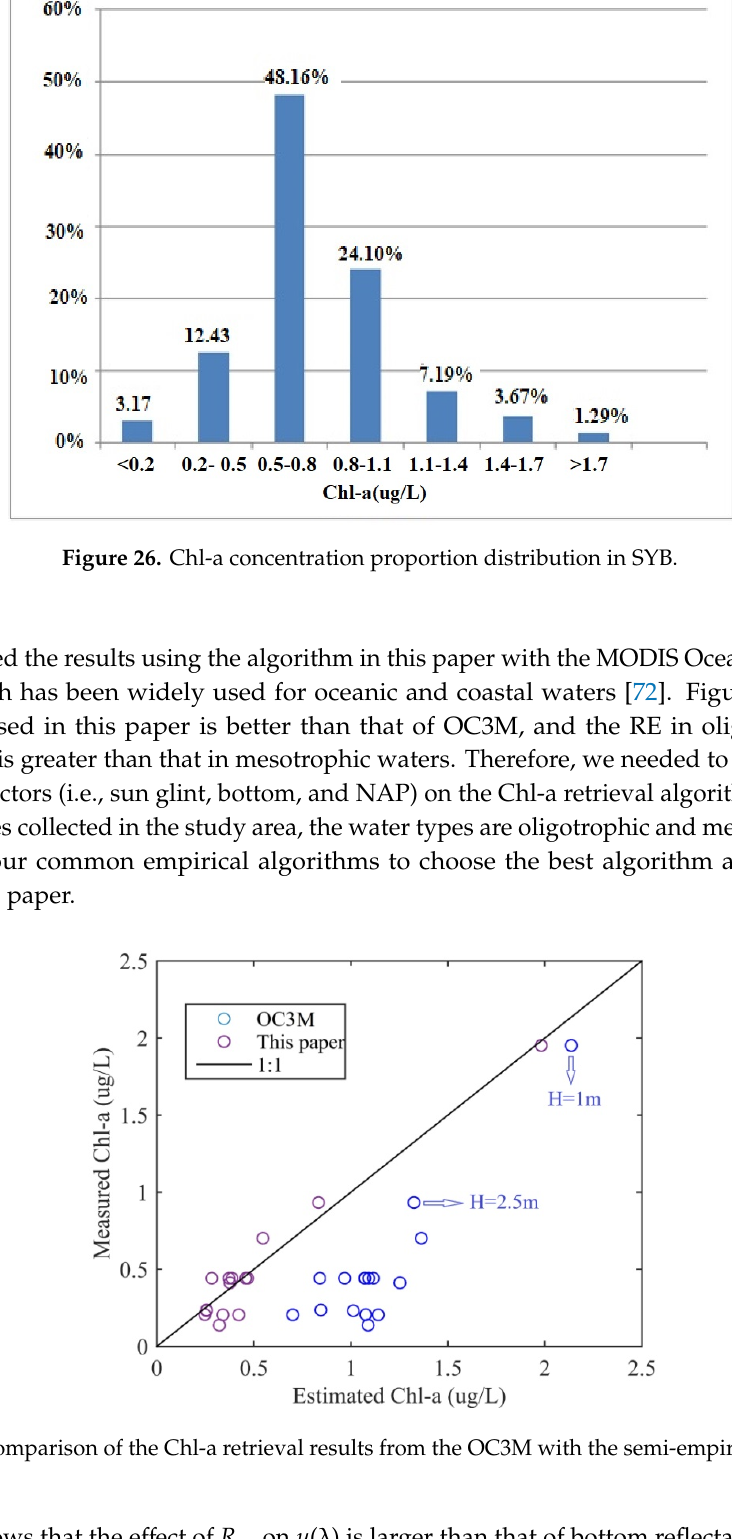
Figure 25. Chl-a concentration retrieval using a phy (490) in SYB.